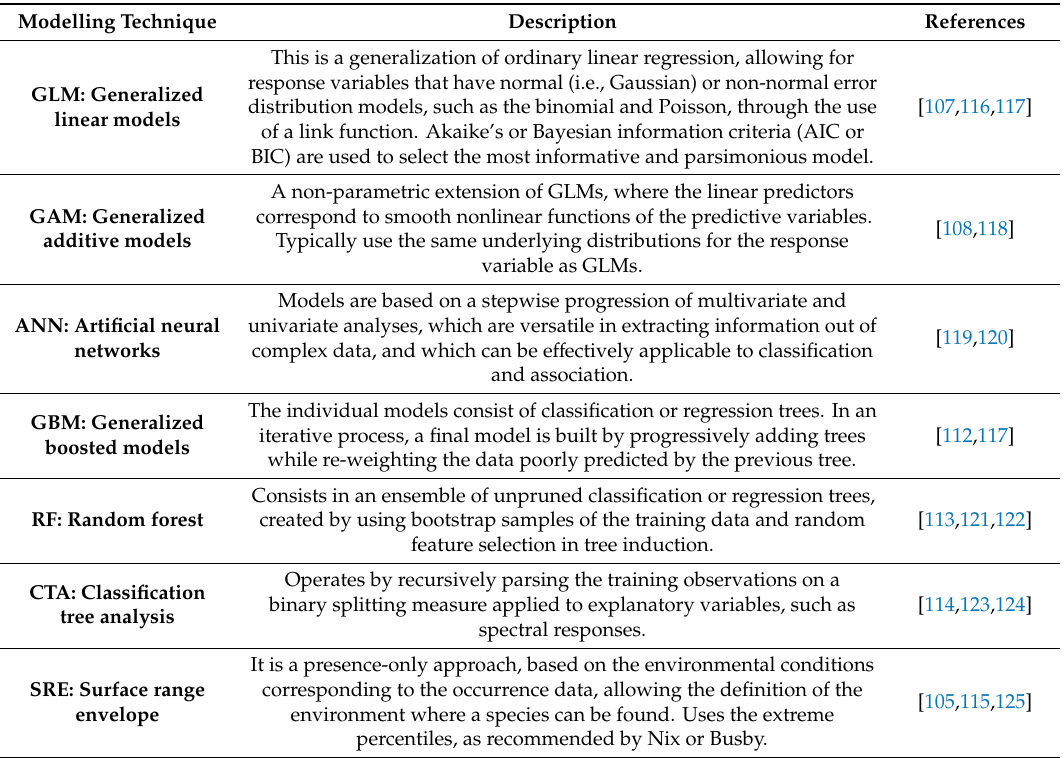
Table 3. Modelling algorithms